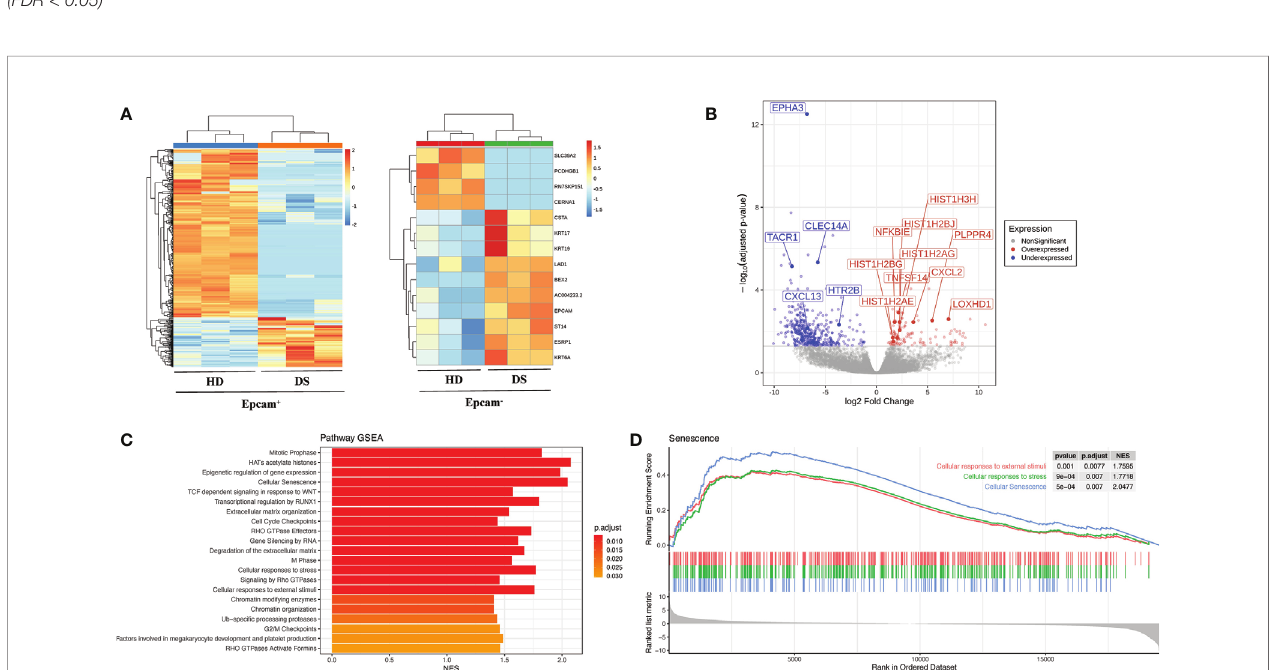
FIGURE 2 | Transcriptomic pro fi le of human TEC in HD and DS patients. (A) Heatmaps showing the expression of differentially expressed genes (DEGs) between normal subjects (HD) and DS patients in Epcam+ (left) and Epcam- (right) cell subsets. (B) Differentially expressed genes (DEGs) between DS and HD Epcam + cell subsets. Log2 fold change and FDR-adjusted p-values are reported for each gene. Volcano plot showing signi fi cant (FDR < 0.05) down- (blue) and up- (red) regulated genes between DS and normal patients in Epcam+ cell subset. Differentially expressed genes of interest are highlighted. (C) Signi fi cantly enriched terms resulting from the GSEA against the REACTOME Pathway database of genes ranked according to logFC values, resulting from the comparison between DS and normal subjects (HD) in Epcam+ samples. (D) Enrichment plot showing the GSEA results of three senescence-related terms on gene pre-ranked based on logFC values resulting from the comparison between DS and normal patients in Epcam + cell regulator of telomere length, while TERF2 protects telomers associated to cellular senescence: H2AX, p16, TERF1 and TERF2 from degradation and fusion and both of them are involved in ( Figure 3D ). H2A histone family member X (usually abbreviated cellular senescence and in aging processes (26). Real time PCR as H2AX) is a type of histone protein from the H2A family analysis detected higher expression of all these genes in digested involved in all senescence mechanisms (25). TERF1 is a negative